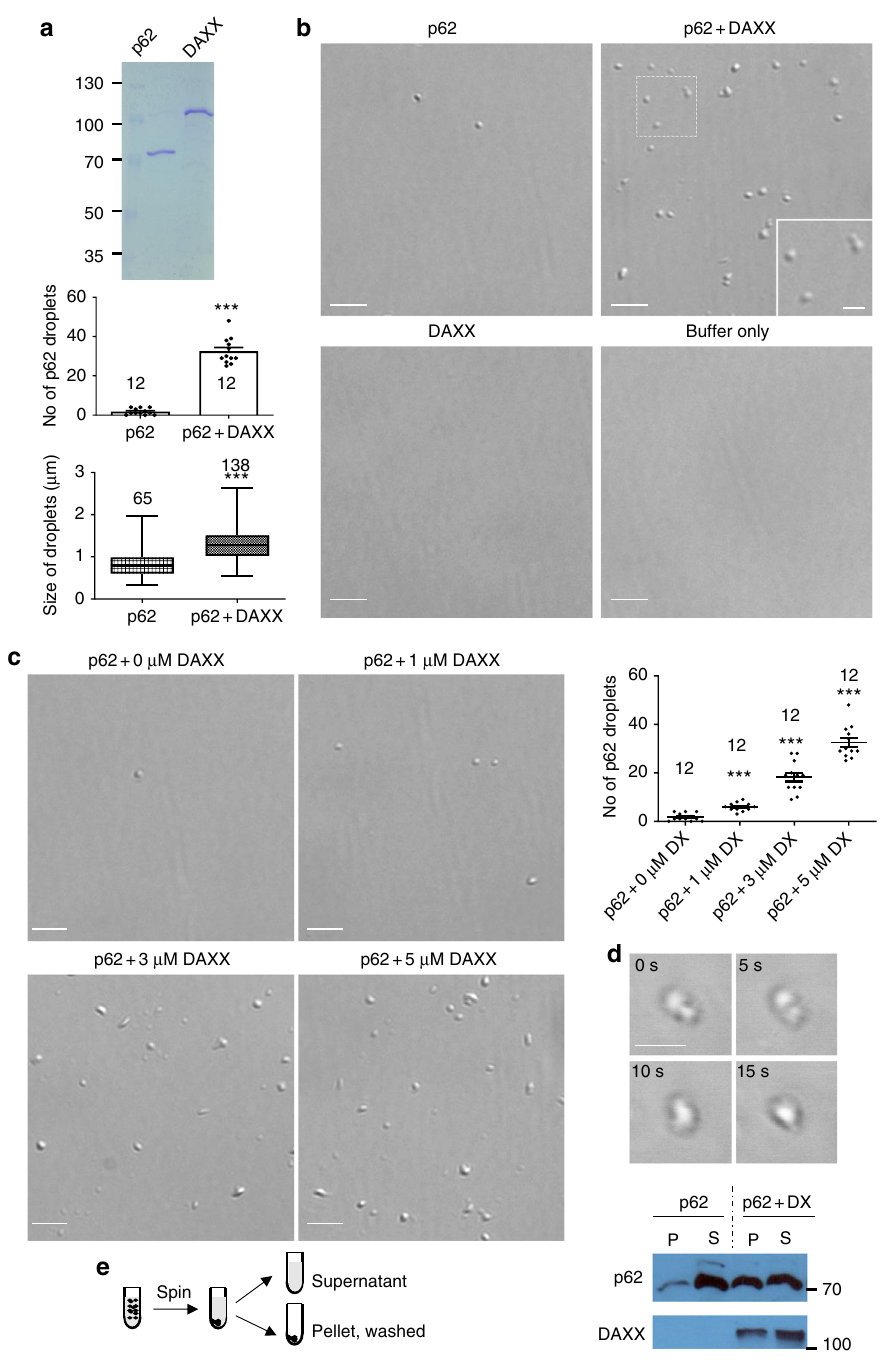
ubiquitinated proteins 39,56 , we investigated if DAXX modulated the p62-polyubiqitinated proteins interaction. DAXX over- localisation (Fig. 7a), as well as the sizes of p62 bodies and